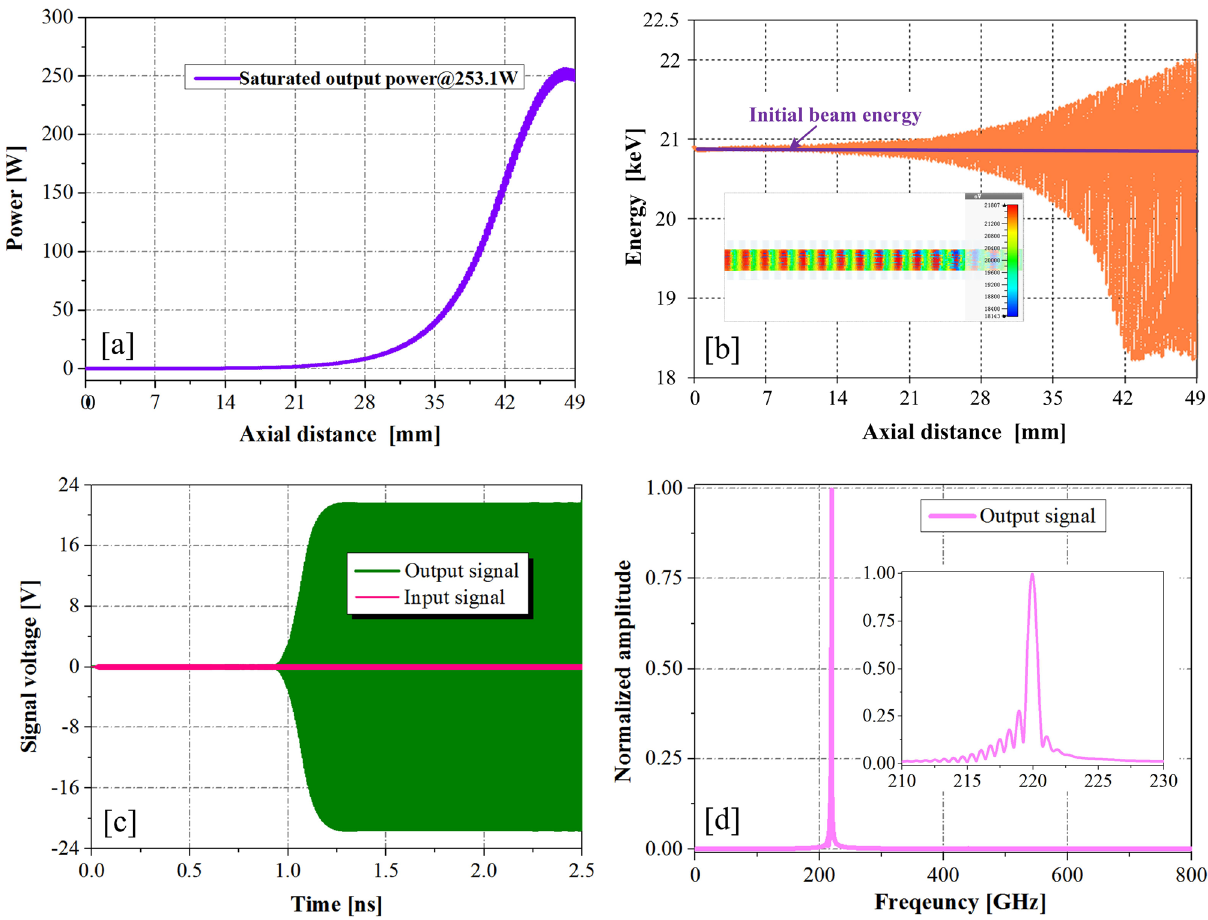
Figure 13. PIC simulation results (from CST) at 220 GHz. ( a ) Output power of the PWSWG interaction circuit as the function of the longitudinal distance. ( b ) The electron energy versus longitudinal distance. The inset shows the electron bunching at the end of interaction circuit. ( c ) Input and output signals. ( d ) Frequency spectrum of output signal.